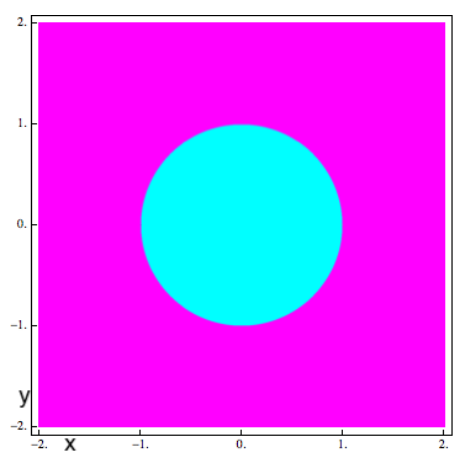
Figure 8. Basins of attraction associated with Jarratt’s method